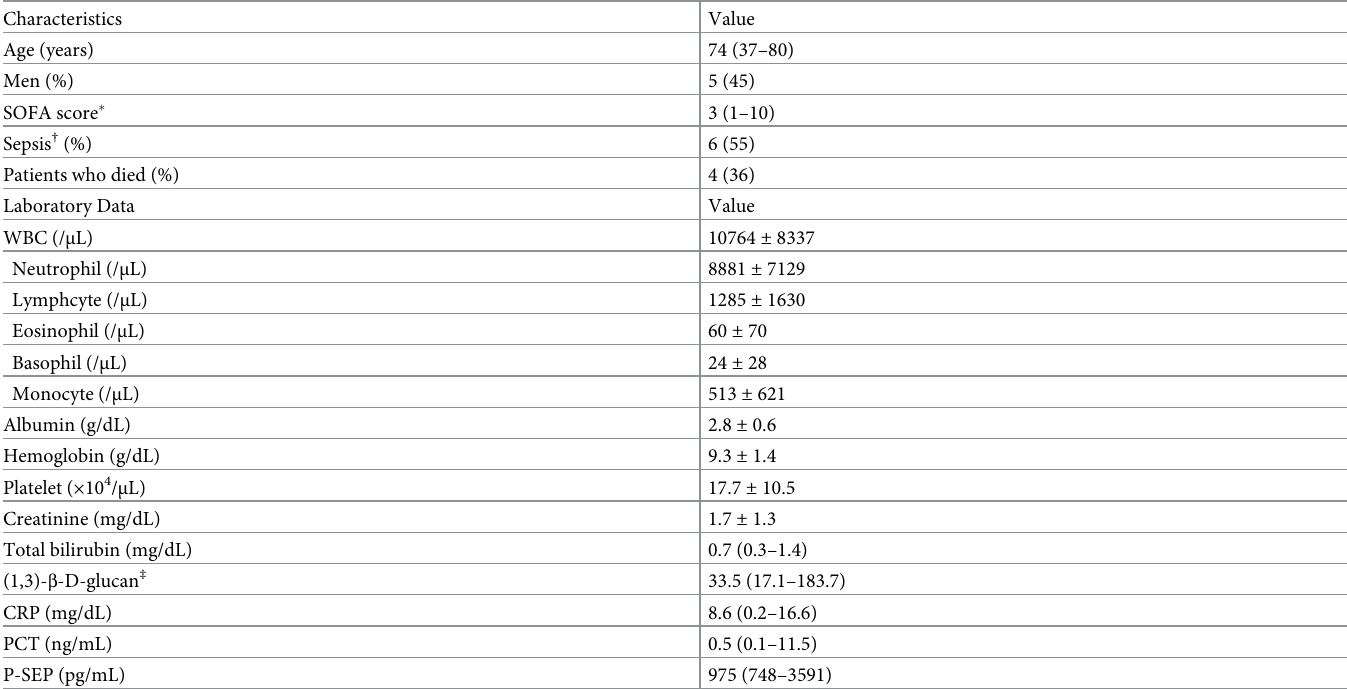
Table 2. Characteristics and laboratory data of 11 patients with